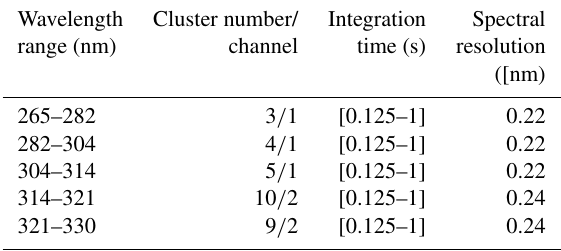
Table 1. SCIAMACHY Level-1 data characteristics in the range 265–330nm used for ozone profile